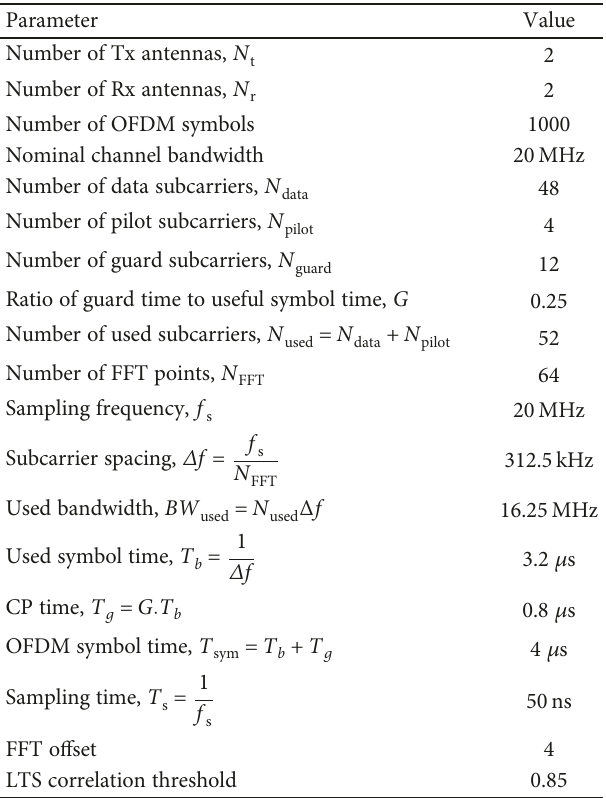
Table 1: MIMO-OFDM parameters.